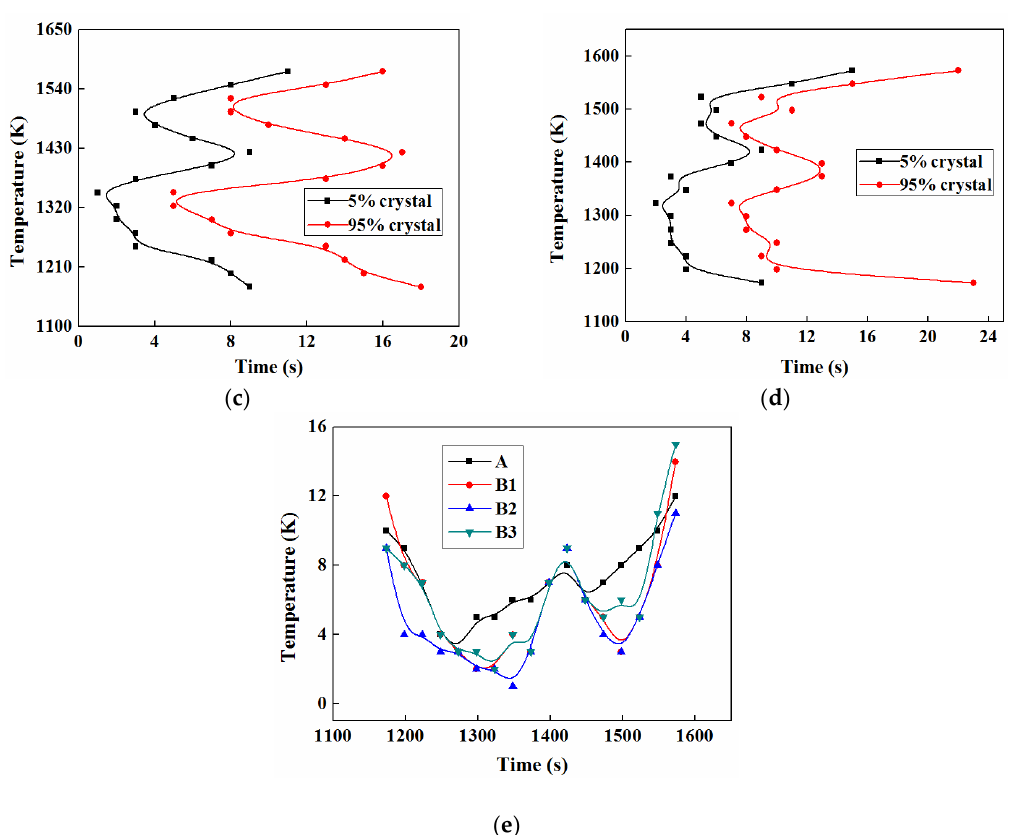
Figure 8. TTT curves of mold fluxes: ( a ) A, ( b ) B1, ( c ) B2, ( d ) B3, ( e ) incubation time of mold fluxes.